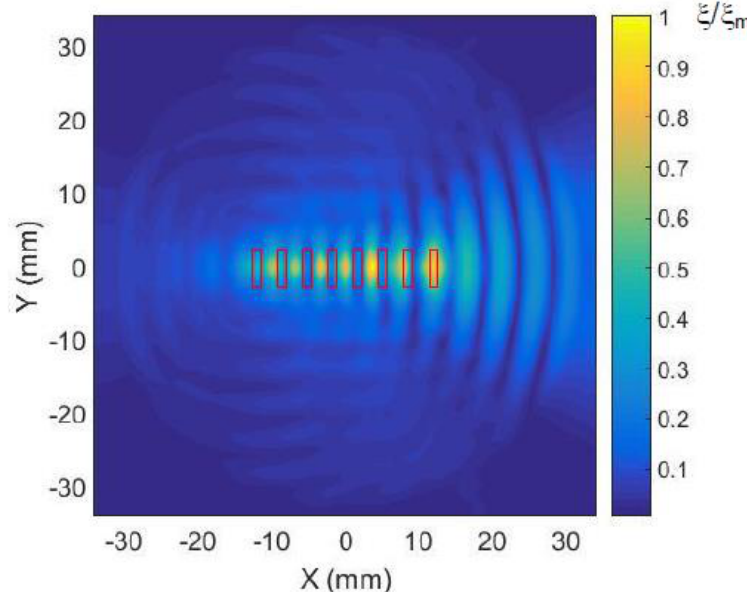
Figure 15. Calculated 2D spatial distribution of normal displacements  of the plastic film excited by the eight-element phased air-coupled array. The presented amplitude values shown in the color bar were normalized with respect to the maximum value in the field.